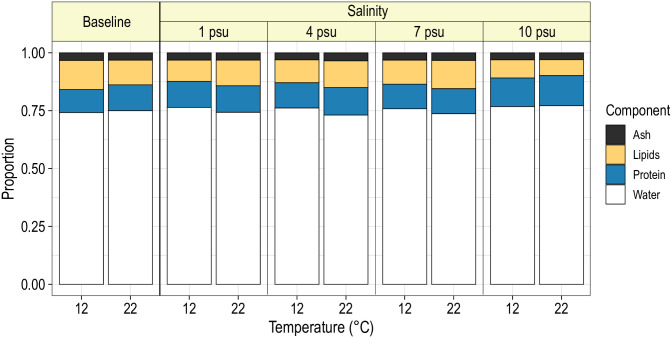
Mean body composition of juvenile blue catfish subjected to one of four salinities at 12 or 22°C for 16 weeks.Baseline refers to mean body composition of blue catfish prior to exposure to salinity treatments. Predictions are for a fish with wet weight of 96.5 g (average weight of fish in the analysis).